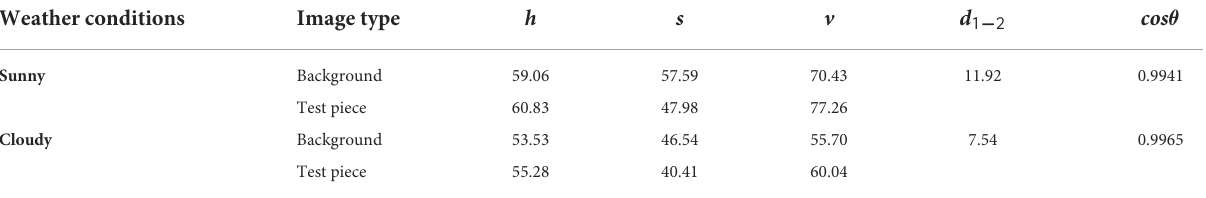
TABLE 6 The similarity between the test piece and background under different meteorological